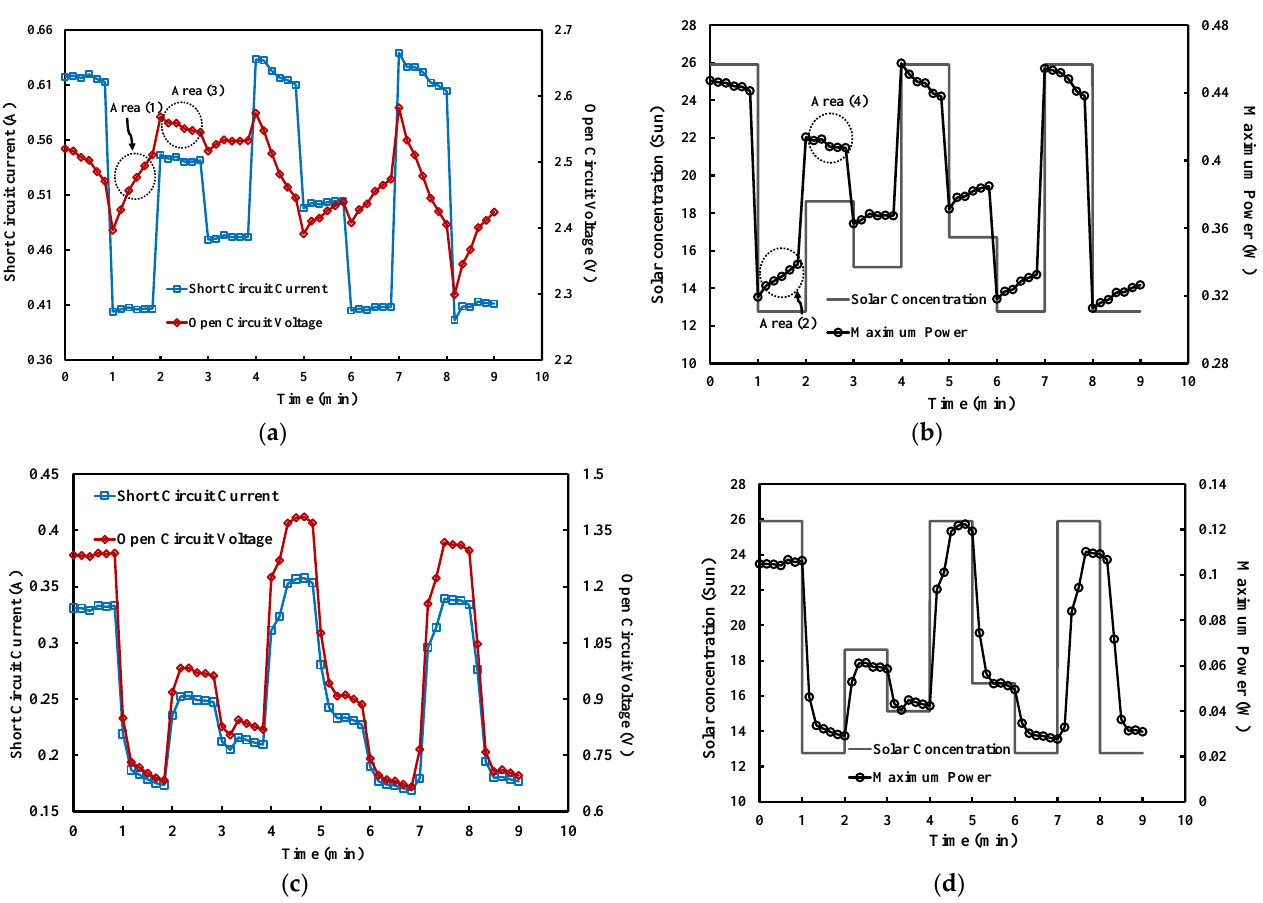
Figure 5. Maximum power, solar concentration, open-circuit voltage, and short-circuit current by ( a , b ) PV cell and ( c , d ) TE module in TE-PV-BS system.